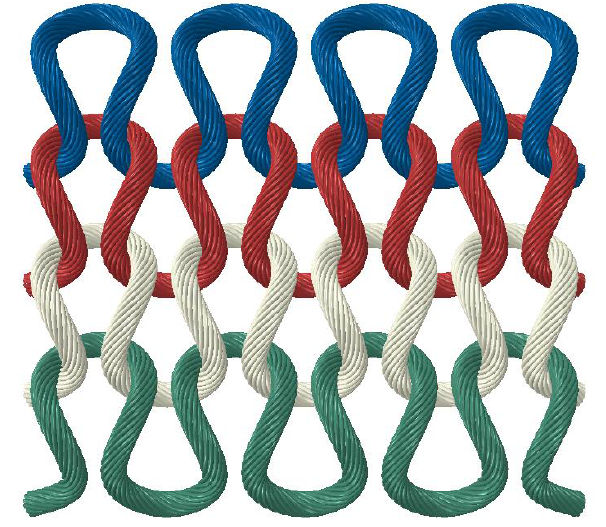
Figure 5. Weft knitted 3D model made of twisted multifilament yarns, created in the developed